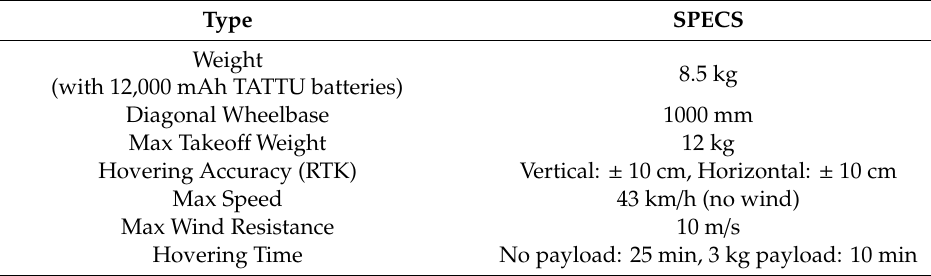
Figure 6. Our 8.5 kg drone platform (including paddles and batteries), which is equipped with three-dimensional (3D) Light Detection and Ranging (LiDAR), an RGB-D camera, an inertial measurement unit (IMU), an optical flow sensor (OFS), a barometer, and a global navigation satellite system (GNSS) receivers (BDS/GPS, RTK). Table 2. UAV Platform specifications.